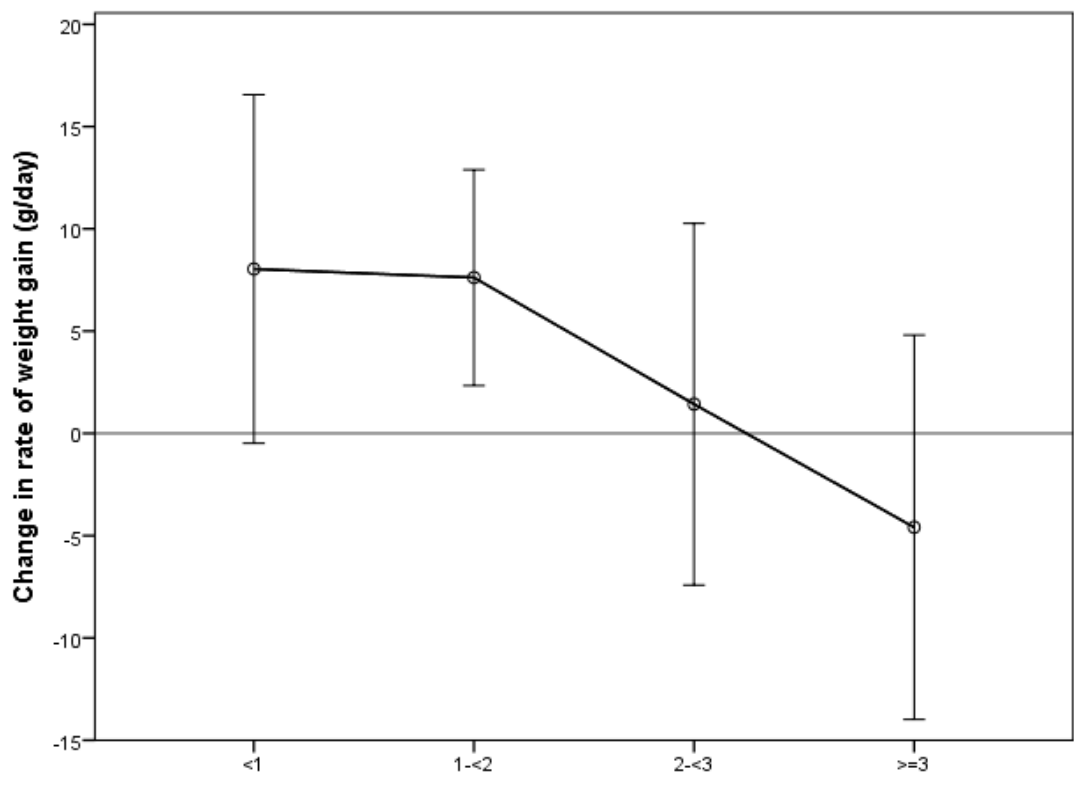
Figure 1. Mean change in rate of weight gain after 34 weeks for infants having <1, 1–<2, 2–<3 and ≥ 3 breast feeds per day. Markers represent mean for group, bars represent 1 standard deviation from mean. Solid line at zero indicates no change in rate of weight gain between growth periods.